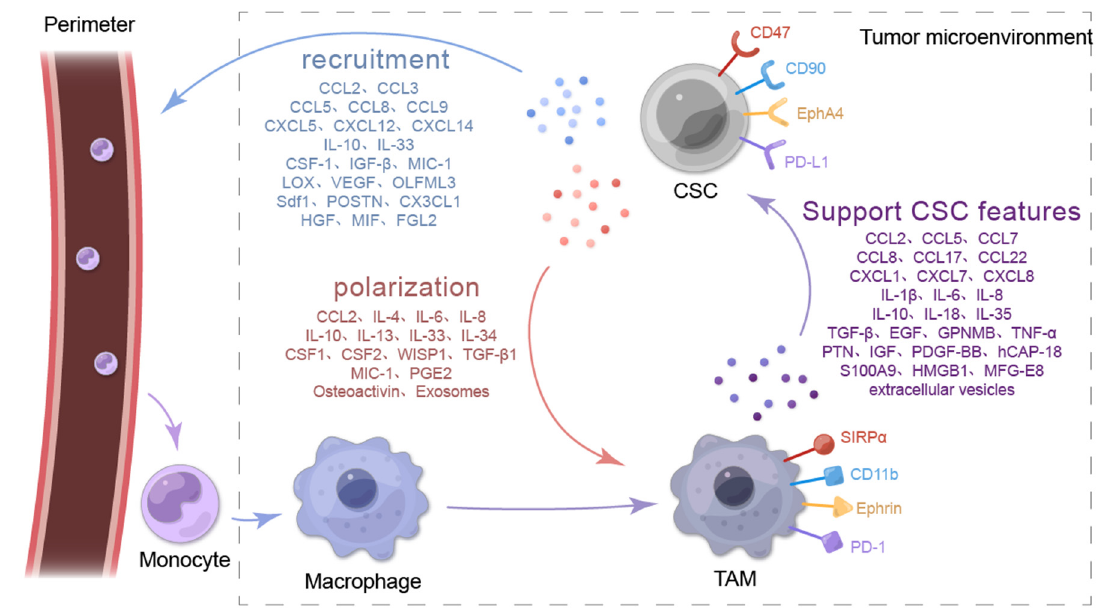
Figure 1. Molecular crosstalk between TAMs and CSCs. CSCs promote macrophage recruitment by secreting CCL2, CCL3, CCL5, CCL8, CCL9, CXCL5, CXCL12, CXCL14, IL-10, IL-33, CSF-1, IGF-